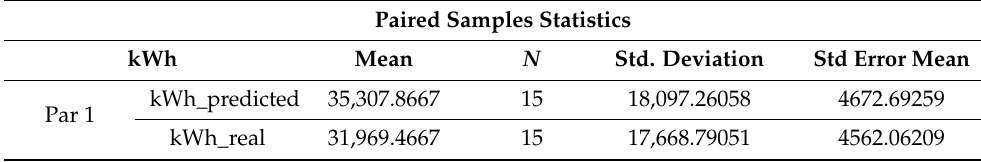
Table 10. Actual and predicted average consumption D3 building.